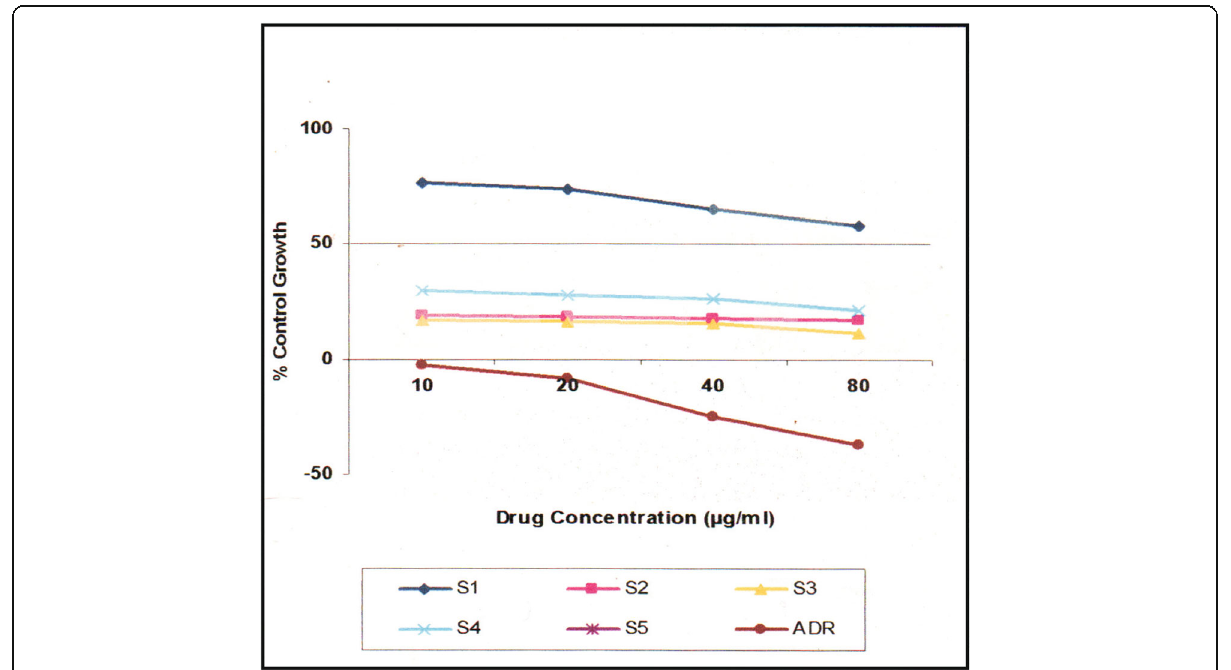
Fig. 3 Growth curve: human lung cancer cell line HOP 62 compounds